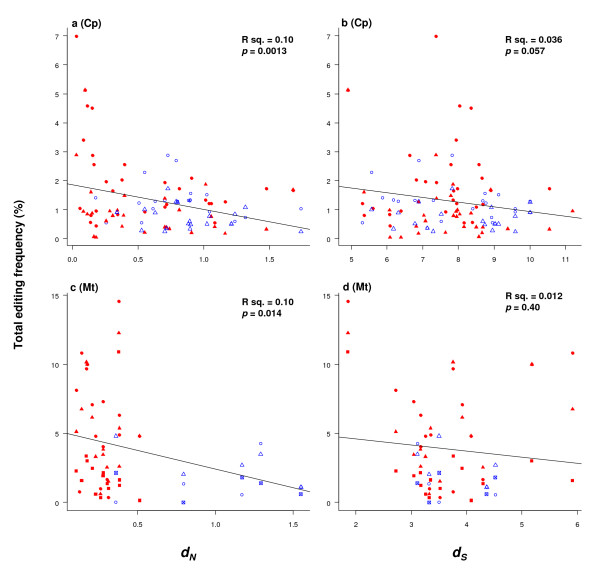
The correlation of total editing frequency and gene specific rates of molecular evolution at nonsynonymous (dN) (a, c) and synonymous (dS) (b, d) sites in chloroplast genomes of A. formosae and A. capillus-veneris (a, b), and mitochondrial genomes of A. thaliana, B. vulgaris, and O. sativa (c, d). Solid points (red) signify membrane-bound proteins, while open points (blue) represent soluble proteins. Data for A. formosae are shown as triangles, while A. capillus-veneris is presented as circles (a, b). Data for A. thaliana, B. vulgaris, and O. sativa are presented as squares, triangles, and circles respectively (c, d).